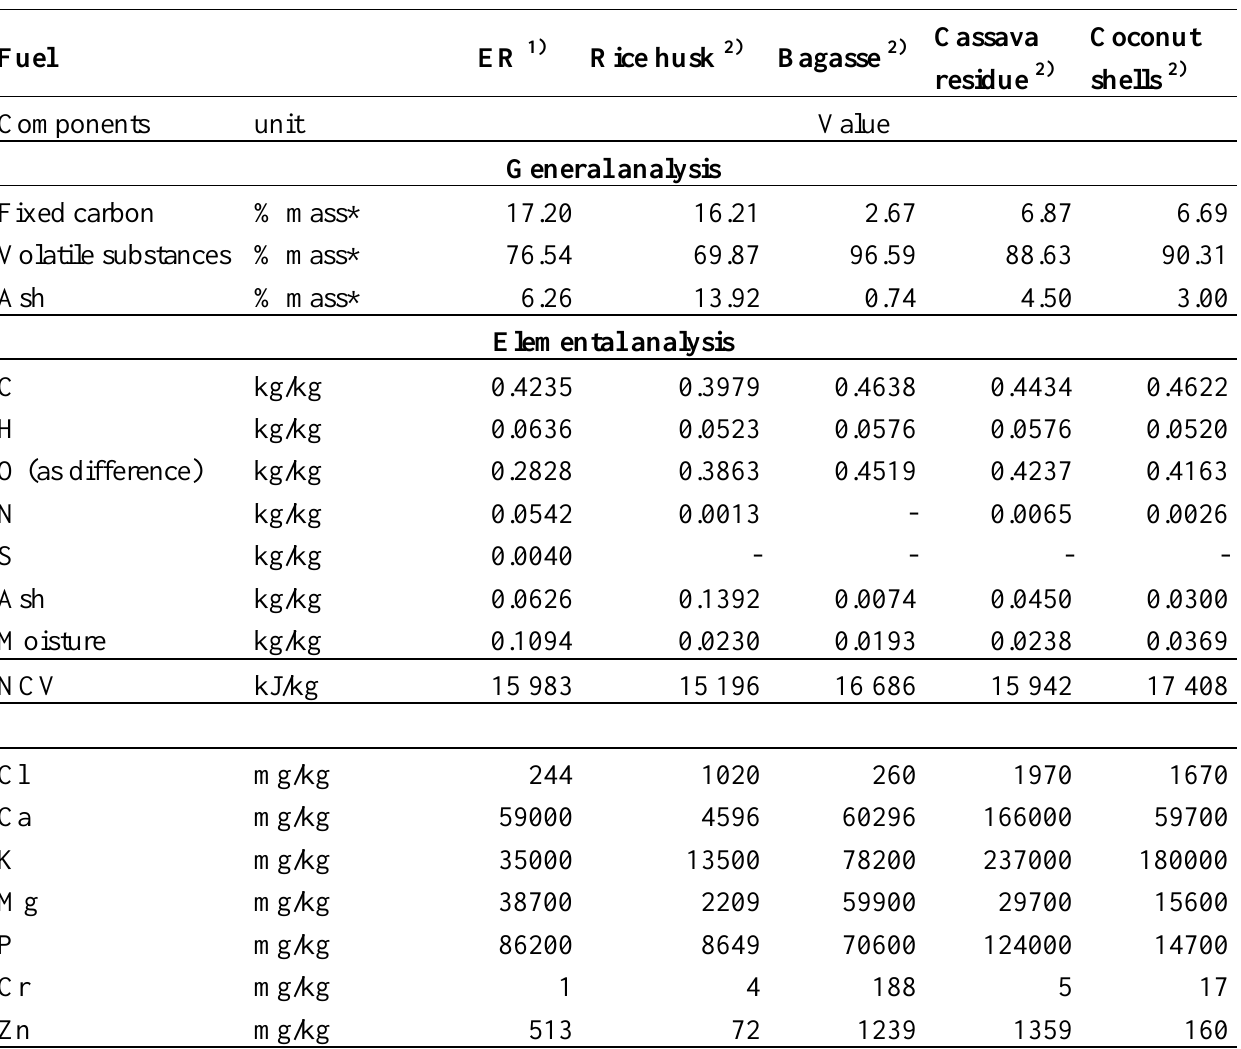
Table 3. Chemical compositions and NCV of typical biomass fuels (General and elemental